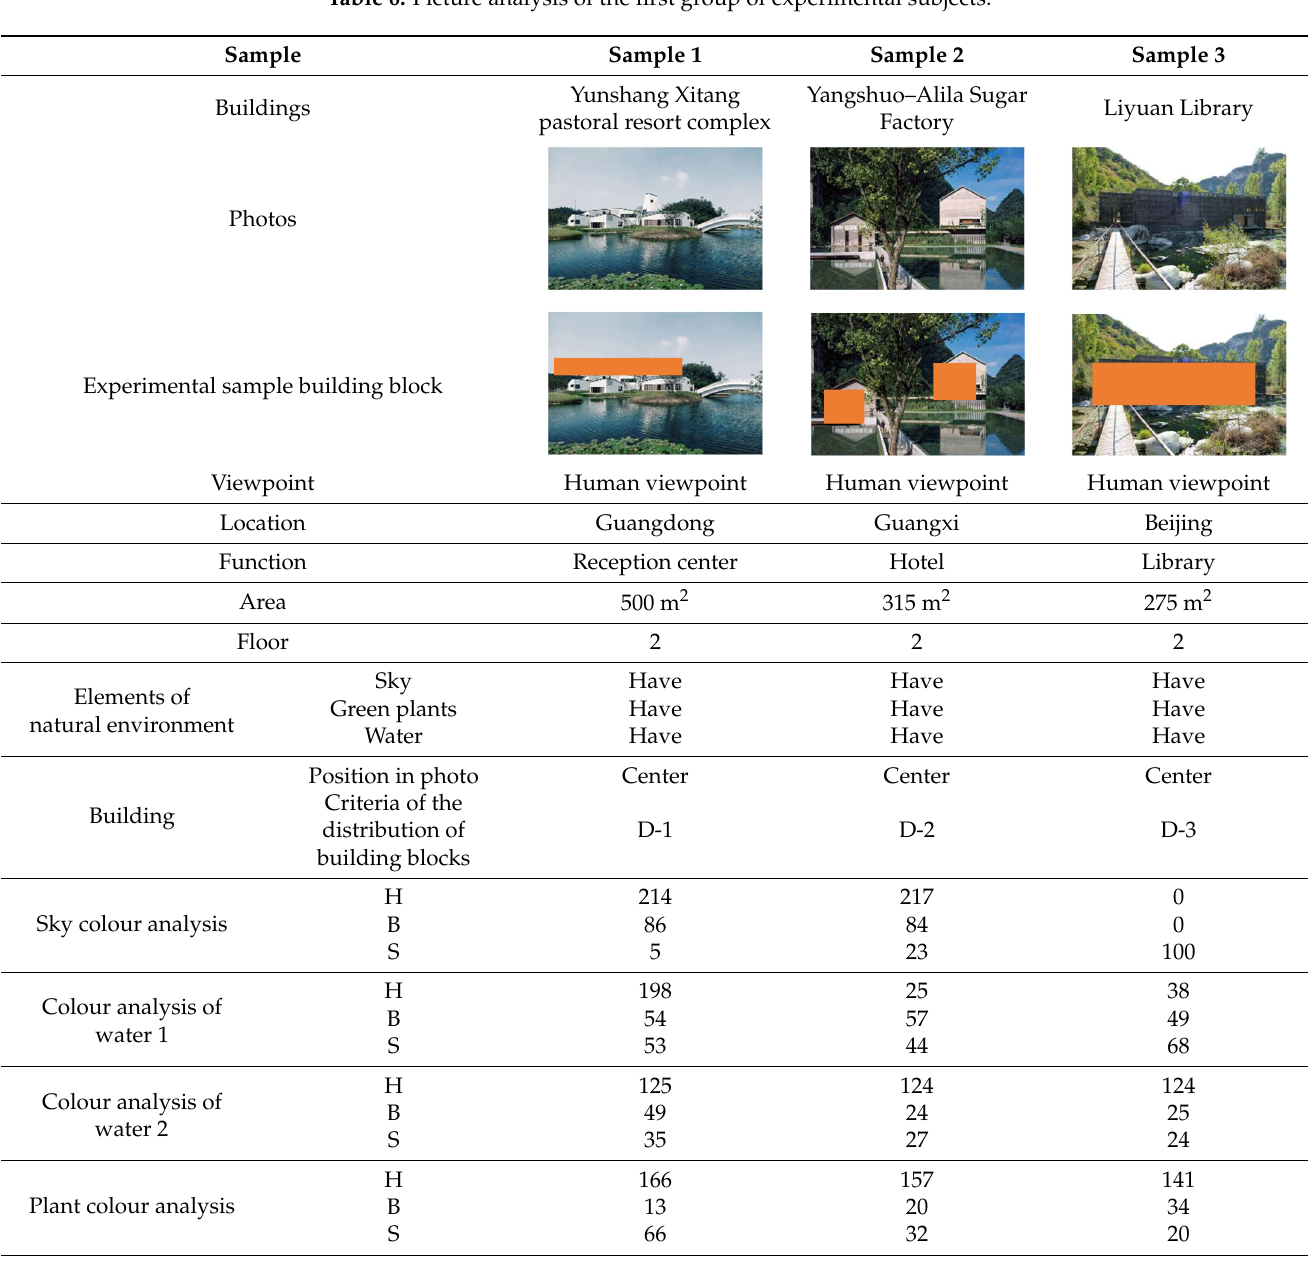
Table 6. Picture analysis of the first group of experimental subjects. Sample